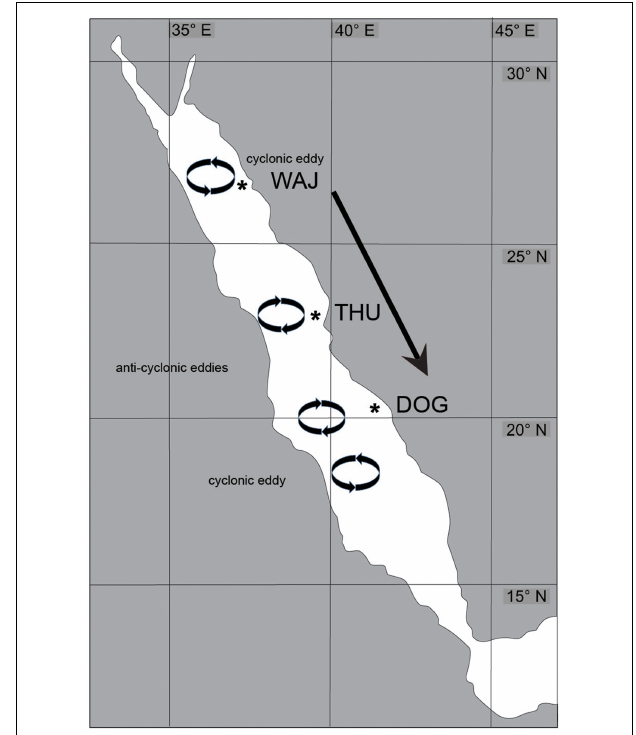
FIGURE 2 | Overview of Pocillopora verrucosa sampling sites and wind and current patterns in the Red Sea. Sampling sites WAJ (north), THU (central), and DOG (south) are indicated by an asterisk. The predominant wind direction among the study sites is from North to South (arrow). A permanent cyclonic eddy influences current direction in the northernmost part (circle) and is followed by two anti-cyclonic eddies (circles). The southernmost circle visualizes the presence of another cyclonic eddy in this area. The flow directions created by these eddies potentially influence coral larval transport across the Red